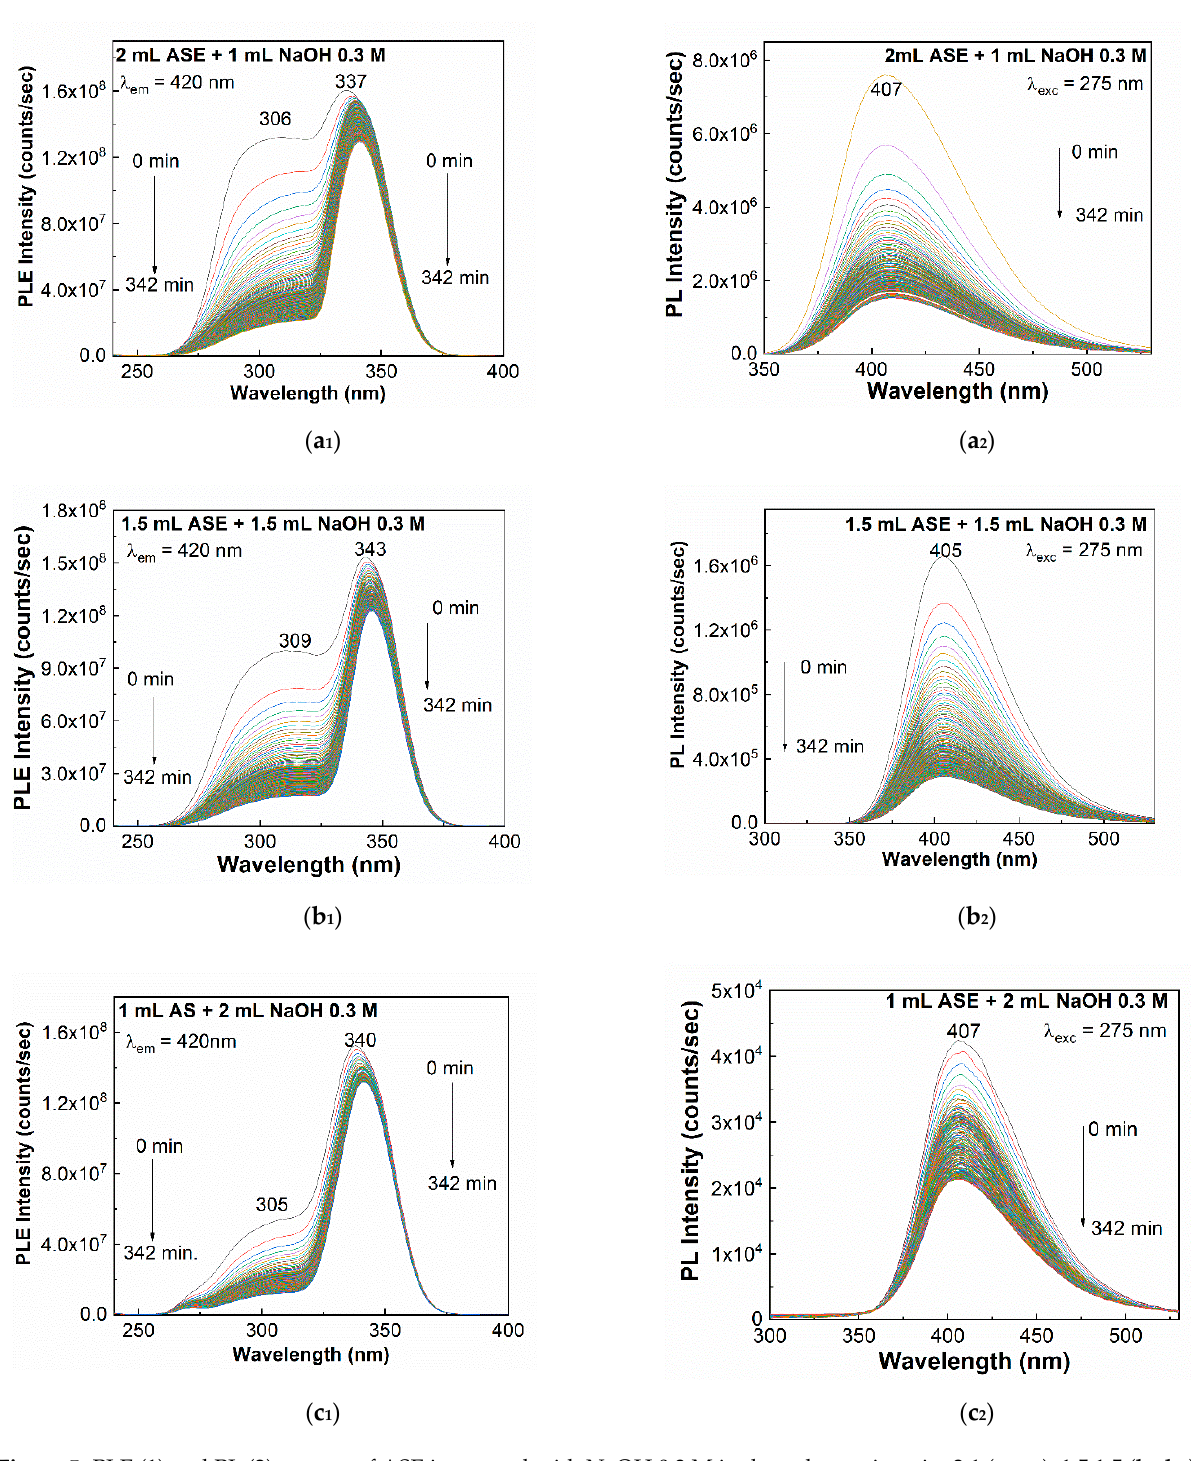
Figure 5. PLE (1) and PL (2) spectra of ASE interacted with NaOH 0.3 M in the volumetric ratio: 2:1 ( a 1 , a 2 ), 1.5:1.5 ( b 1 , b 2 ), and 1:2 ( c 1 , c 2 ). PLE and PL spectra were recorded at the emission wavelength equal to 420 nm and the excitation wavelength equal to 275 nm, respectively.